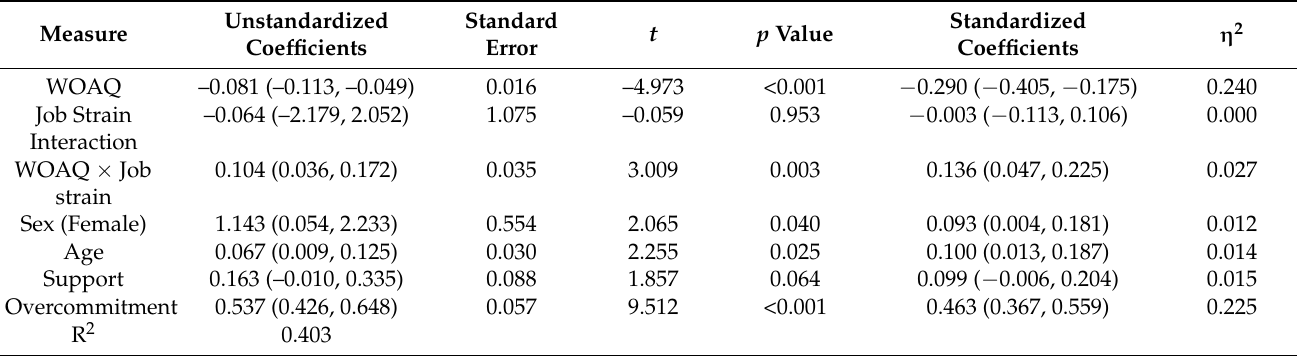
Table 4. Adjusted direct and indirect associations of work organization with psychological health (measured by GHQ12) moderated via job strain. Moderation analysis.